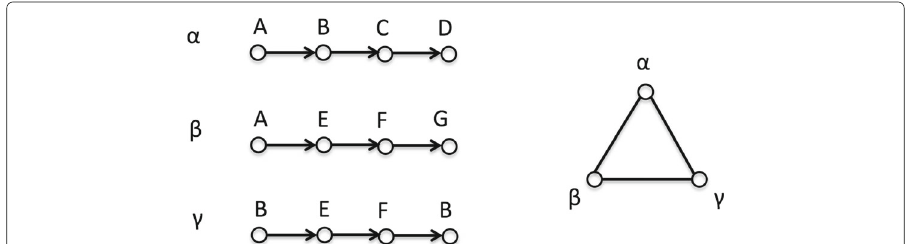
Fig.1 Three information walks with nodes from A, B ... G, and the corresponding network of information